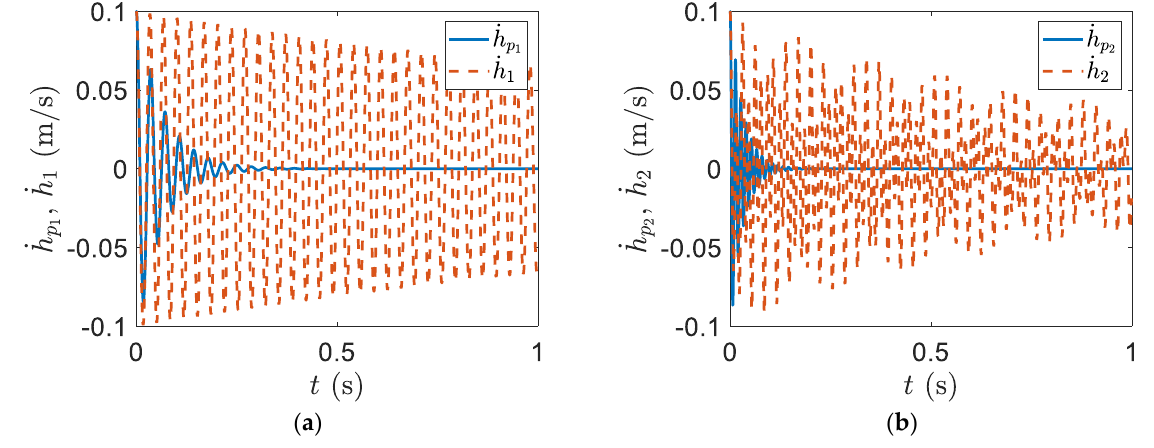
Figure 2. The smart blade system responses of the velocity: ( a ) flapwise oscillation; ( b ) edgewise The smart blade system responses of the velocity: ( a ) flapwise oscillation; oscillation. ( b ) edgewise oscillation.